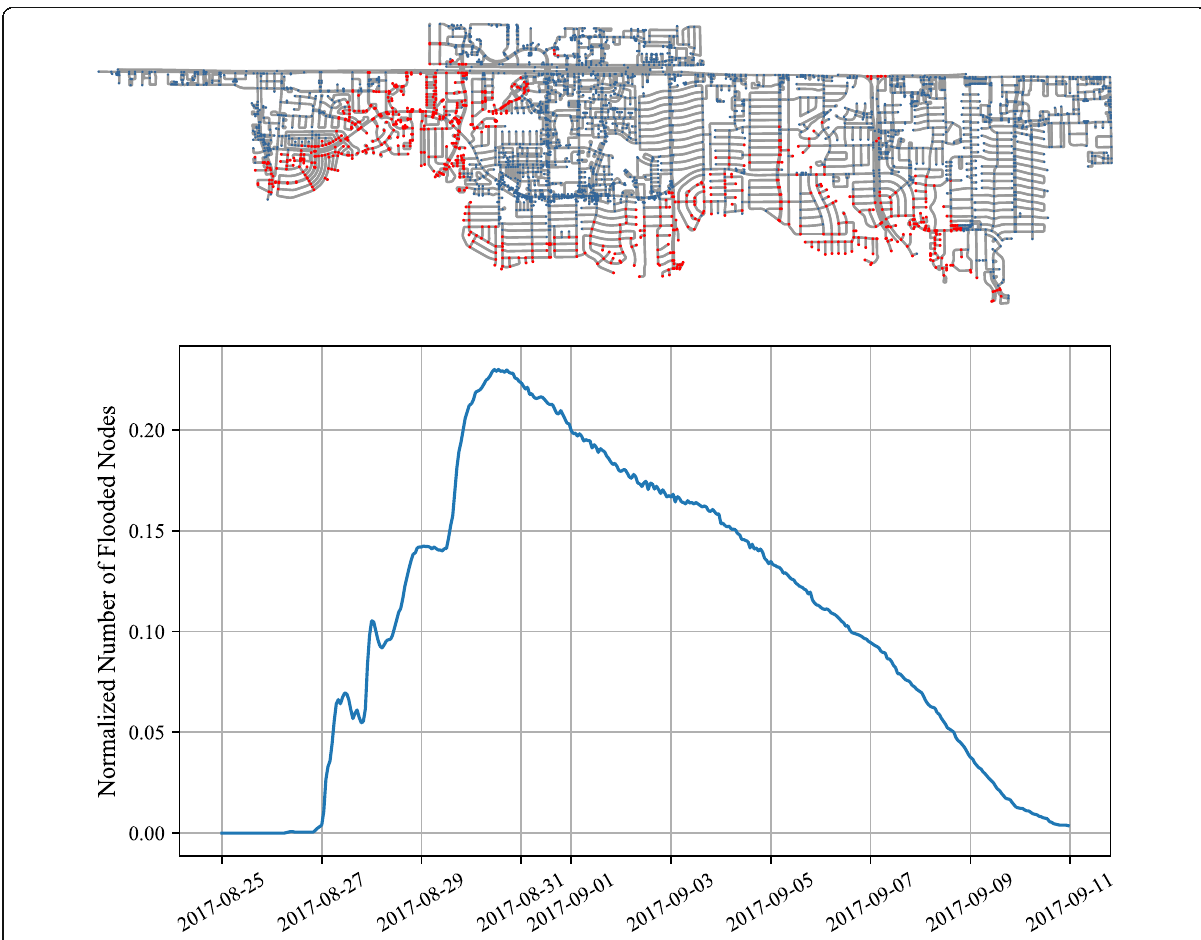
Fig. 4 Road network under maximum flooding (top); Temporal change in the normalized number of inundated nodes in the Memorial road network